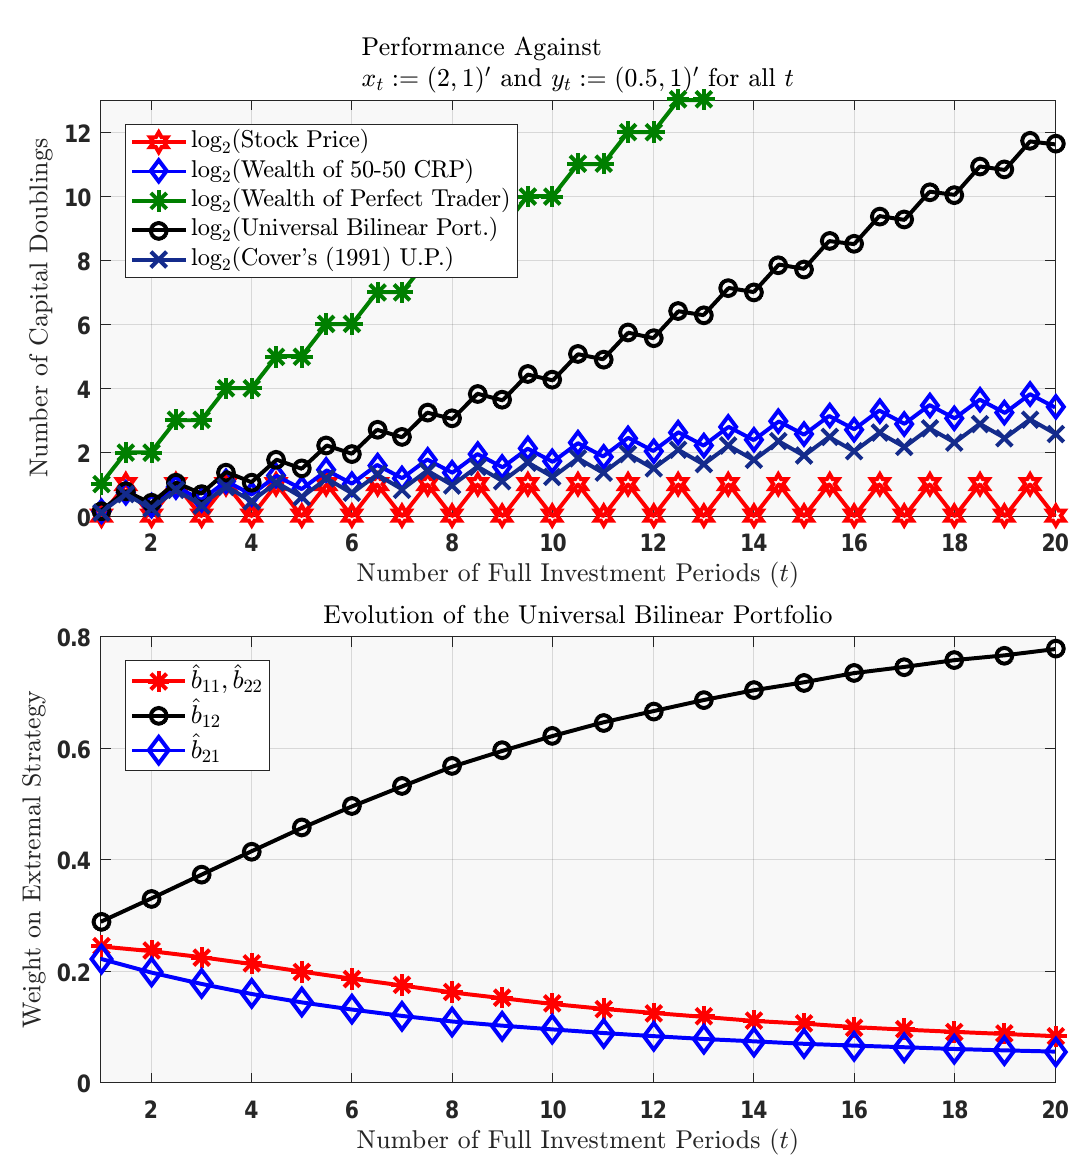
Figure 2. Superior performance of the universal bilinear portfolio against the individual return sequence x t : ≡ ( 2,1 ) (cid:48) and y t : ≡ ( 0.5,1 ) (cid:48) . Asset 2 is cash (that pays no interest); asset 1 is a “hot stock” that doubles in the first half of each investment period and loses 50% of its value in the latter half of each investment period. Note that in the bottom plot, we have lim t → ∞ ˆ b 12 ( x t , y t ) = 1 and ˆ b 11 ( x t , y t ) ≡ ˆ b 22 ( x t , y t ) ∼ 1/ t →